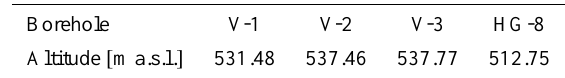
Table 1. Altitude of boreholes at AGO